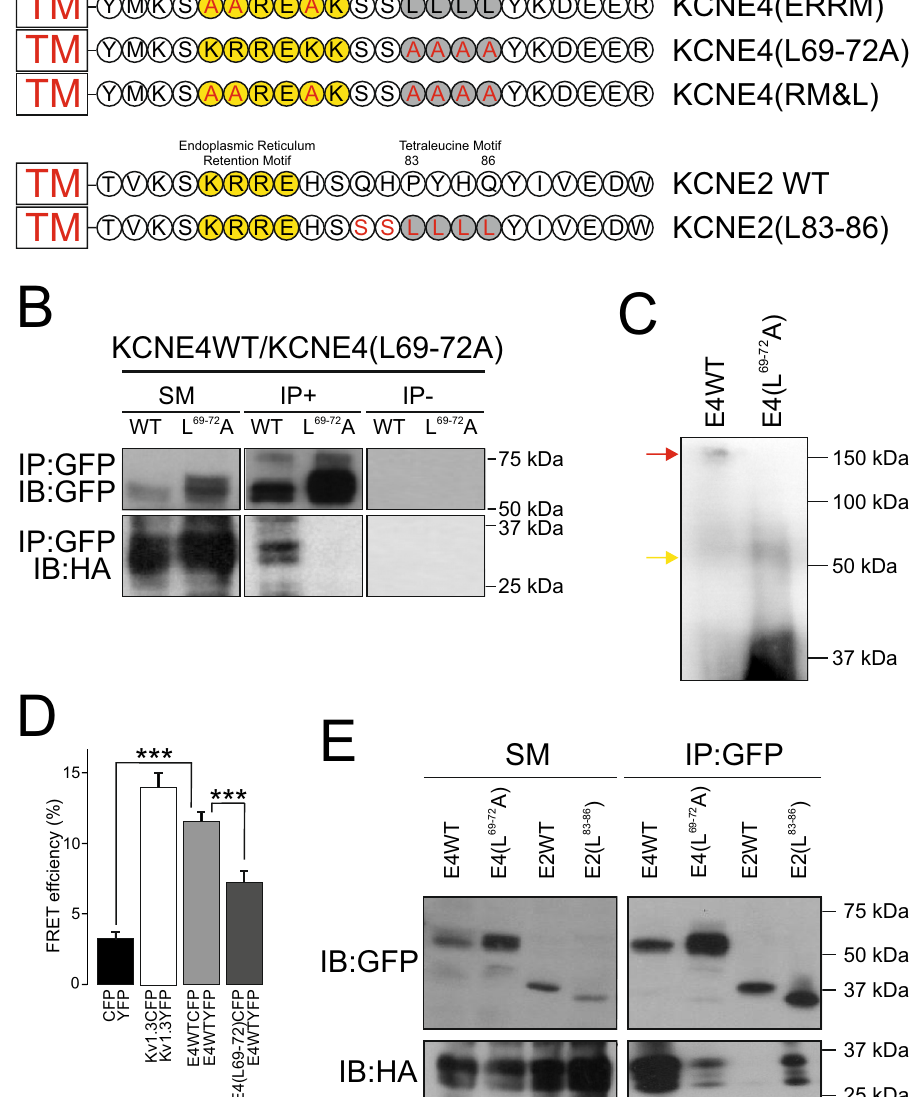
Figure 5. The juxtamembrane tetraleucine motif is critical for KCNE4 dimerization. ( A ) Representative cartoon showing the sequence alignment of the juxtamembrane segment of KCNE4 and KCNE2 and the comparison with the introduced mutations. The transmembrane domain (TM) is shown in a box in red. The KCNE ERRMs are in yellow. The tetraleucine signature is colored gray. Amino acid substitutions are highlighted in red. For KCNE4 (ERRM), the ERRM of KCNE4 was disrupted with alanine residues (in red). For KCNE4 (L69-72A), the tetraleucine motif (gray) was also mutated to alanine (in red). For KCNE4(RM&L), both the ERRM and the tetraleucine L69-72A motifs were disrupted by alanine substitutions. The tetraleucine motif of KCNE4 was introduced in the same location in KCNE2 (KCNE2(L83-86)). (B-D) HEK-293 cells were transfected with KCNE4CFP, KCNE2-HA, Kv1.3-(CFP/YFP) and different KCNE mutants. ( B ) Coimmunoprecipitation assay against KCNE4-CFP and KCNE4(L69-72A)CFP in the presence of KCNE4-HA (IP:GFP). Top panel: Immunoblot against CFP (IB:GFP). Bottom panel: immunoblot against HA (IB:HA). SM: starting material. IP + : Immunoprecipitation in the presence of the anti- GFP antibody. IP-: Immunoprecipitation in the absence of the anti-GFP antibody. KCNE4-HA coimmunoprecipitates with KCNE4CFP (KCNE4WT) but not with KCNE4(L69-72A)CFP. Representative cropped blots are clearly separated by vertical white lines. ( C ) Non- denaturing SDS-PAGE. HEK 293 cells were transfected with KCNE4WT-CFP and KCNE4(L69-72A)CFP and cell lysates immunoblotted against GFP. Note that while KCNE4WT-CFP exhibited large molecular mass forms (red arrow), KCNE4(L69-72A)CFP only appeared as monomers (yellow arrow). ( D ) Quantification of the FRET efficiency of KCNE4 dimerization. Cells were cotransfected with CFP/YFP (negative controls), Kv1.3CFP/Kv1.3-YFP (positive control), KCNE4WT (CFP/YFP) and KCNE4WT-YFP and KCNE4(L69-72A)CFP. The values represent the mean ± SE of n > 25 cells. *** p < 0.001 Student’s t -test. (E) HEK-293 cells were cotransfected with KCNE4WT-HA/ KCNE4(L69-72A)CFP and KCNE4WT-HA and either KCNE2WT-CFP or KCNE2(L83-86)-CFP. Top panels: Immunoblot against CFP (IB: GFP). Bottom panel: immunoblot against HA (IB: HA). SM: starting material. IP: GFP: Immunoprecipitation in the presence of the anti-GFP antibody. KCNE4-HA coimmunoprecipitates with KCNE2(L83-86)-CFP but not with